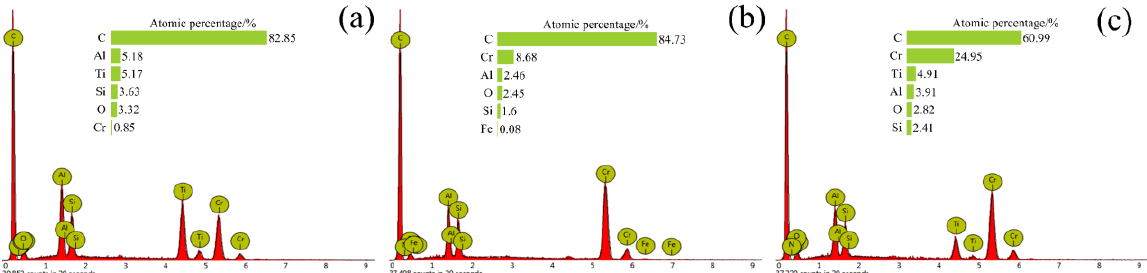
Figure 2. EDS of Si-DLC with different transition layers: ( a ) AlTiSiN/Si-DLC; ( b ) AlCrN/Si-DLC; ( c ) AlTiCrN/Si-DLC.